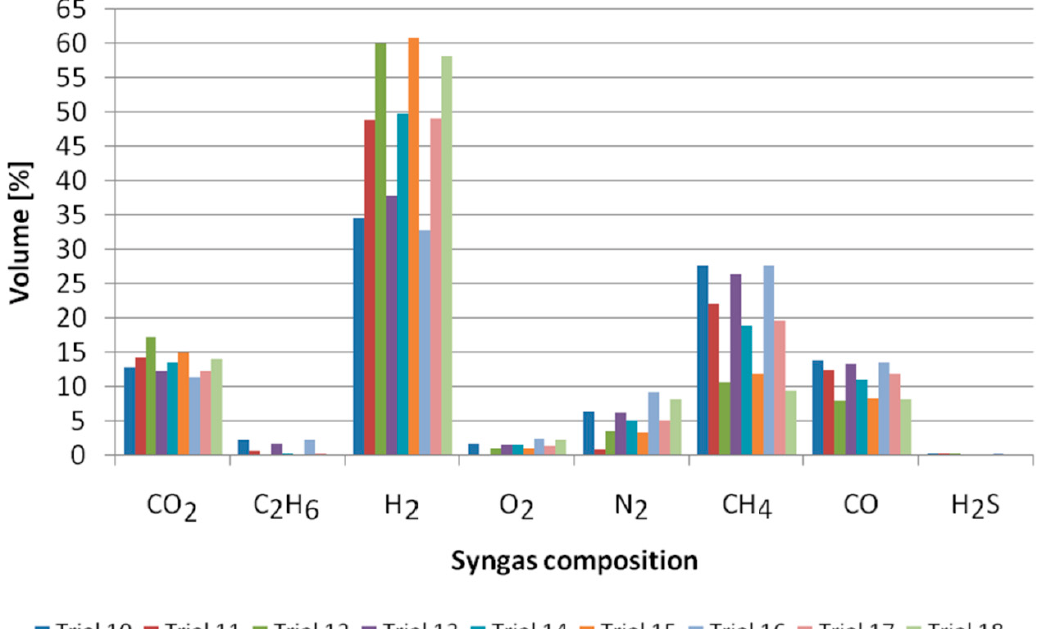
Figure 13. The effect of steam supply on the syngas composition during the gasification of the coal sample from hard coal mine B (on a dry basis).